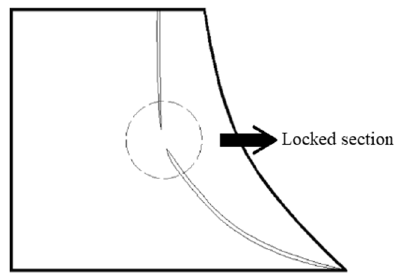
Figure 1. Simplified model of rock slope with locked section.